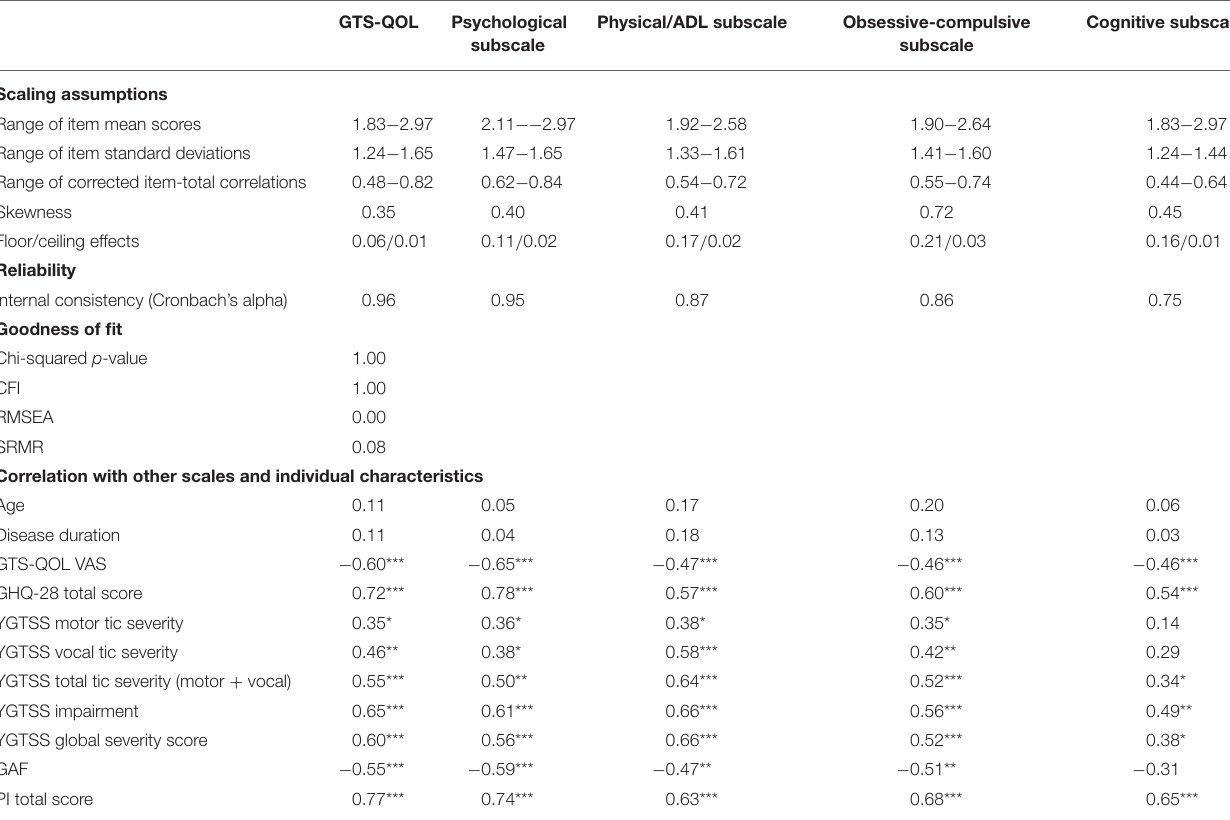
TABLE 4 | Scaling assumptions, reliability, and internal construct validity of the GTS-QOL and of each subscale.